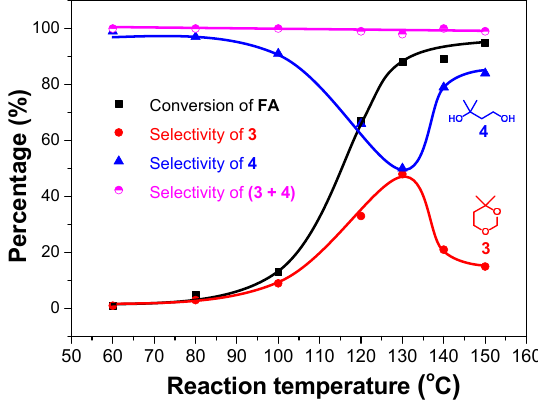
Figure 1. Effect of reaction temperature for the Prins condensation-hydrolysis of isobutene with FA in water over pristine CeO 2 . Reaction conditions: 50 mg CeO 2 , 1.5 mL H 2 O, 0.21 mL HCHO (38 wt %), 3.0 g isobutene, 4 h.